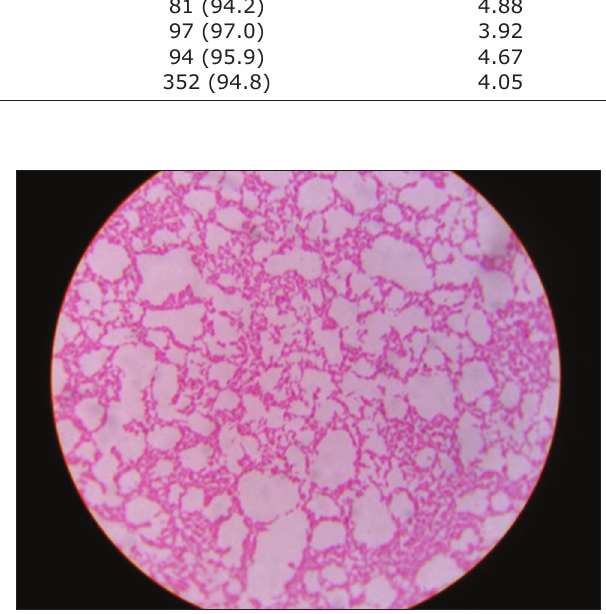
Figure-1: Pink colored bacilli of Pseudomonas aeruginosa isolates in Gram’s staining.